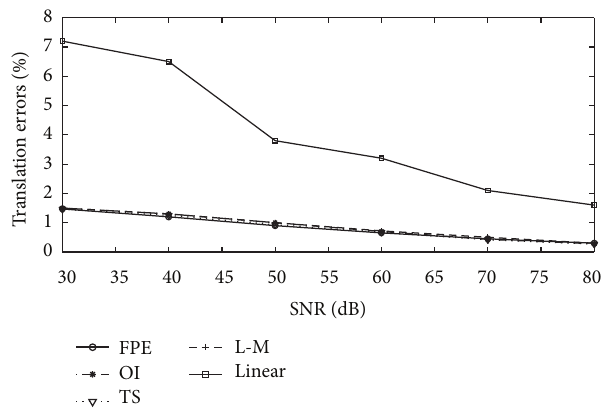
F 6: Translation errors against SNR.